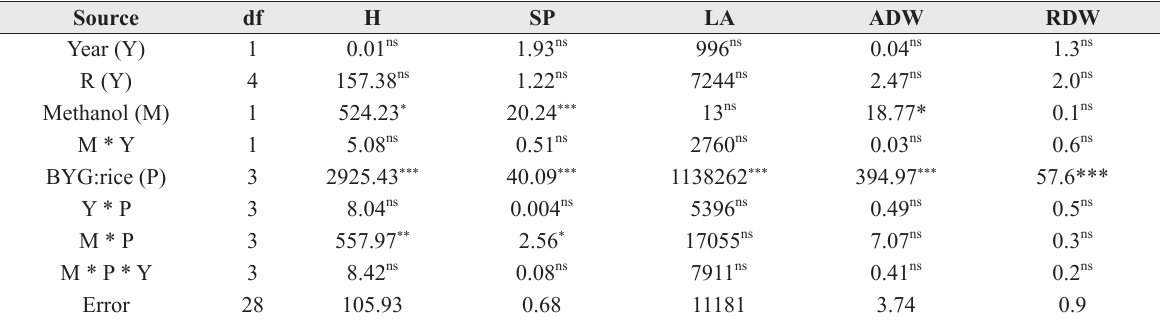
Mean squares for the combined analysis of variance for barnyardgrass (BYG) plant height (H), seed production (SP), leaf area (LA), aboveground dry weight (ADW), root dry weight (RDW) as affected by methanol foliar application (M) and BYG:rice mixture proportion (P).